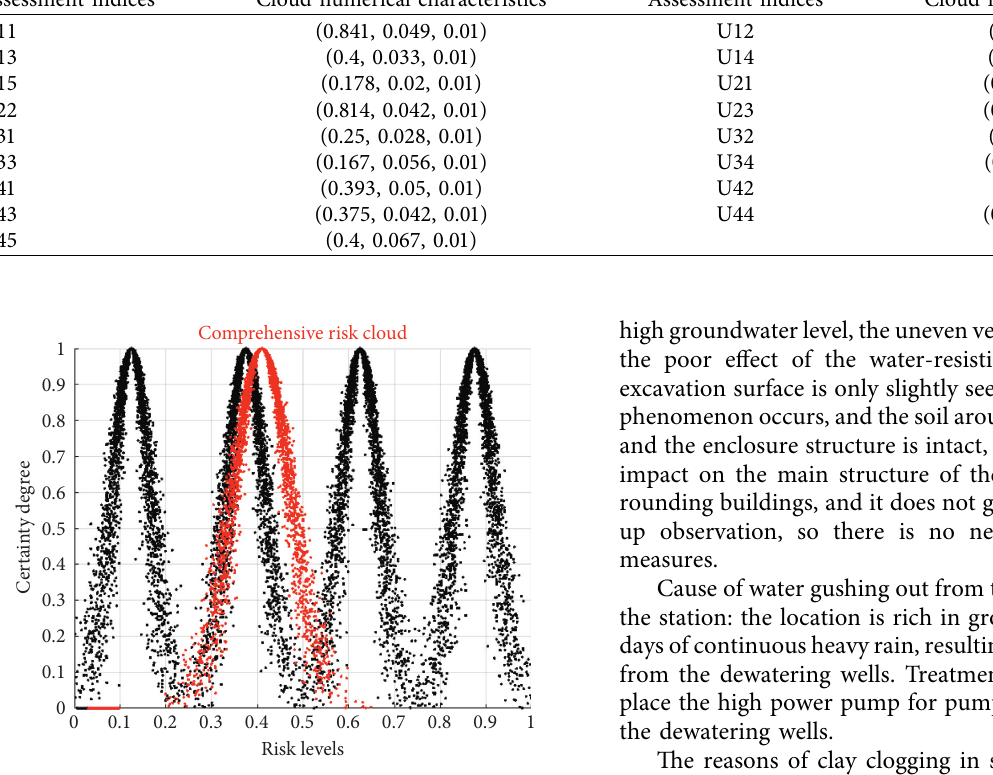
Figure 9: Comprehensive risk cloud diagram.